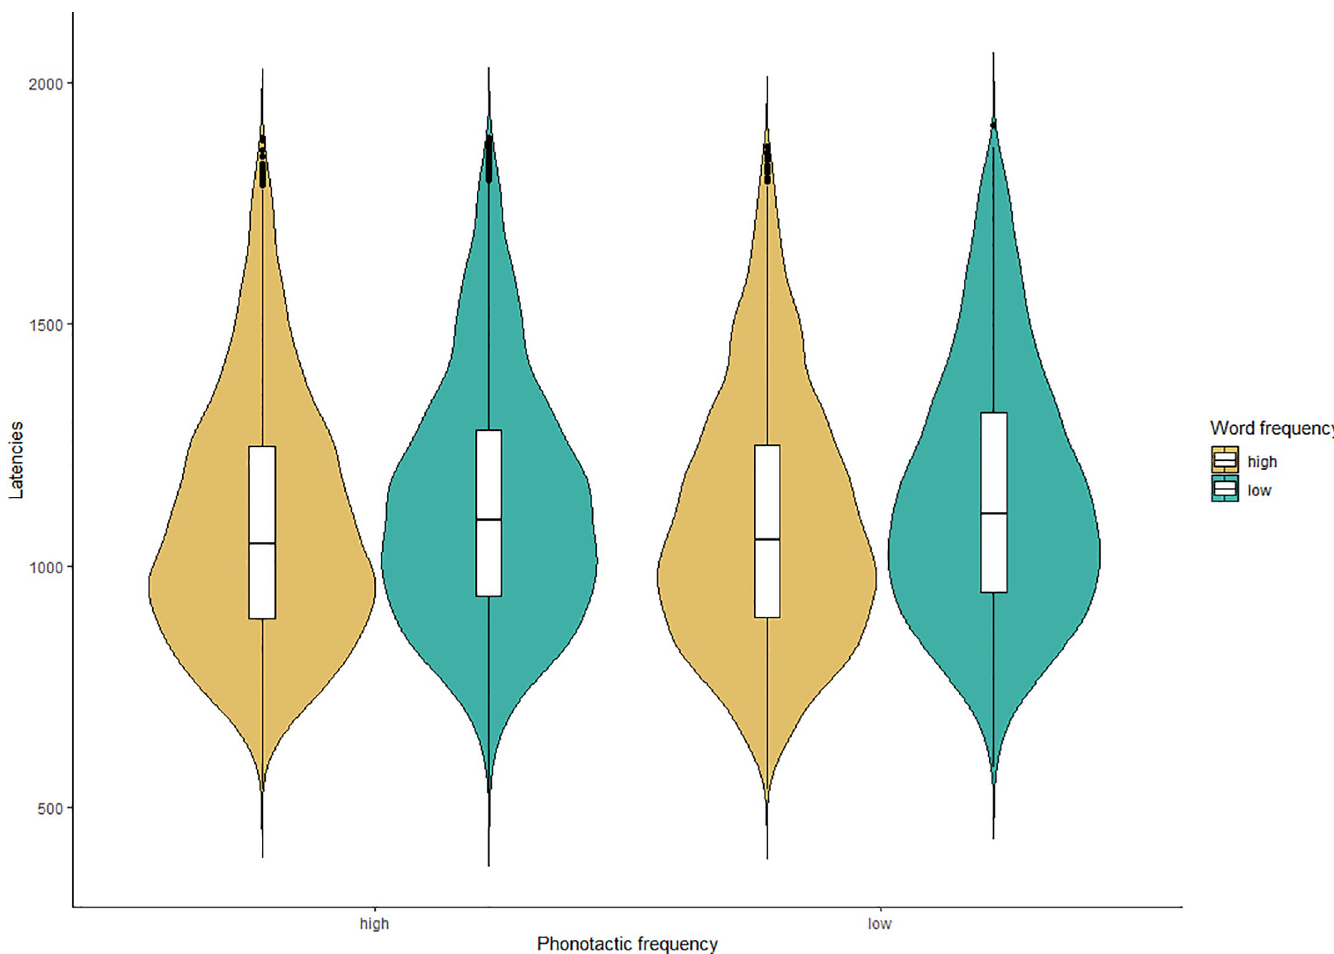
Fig 1. Naming latency distributions. Latencies by word frequency (high: yellow, low: green) and phonotactic frequency (high: left, low: right).